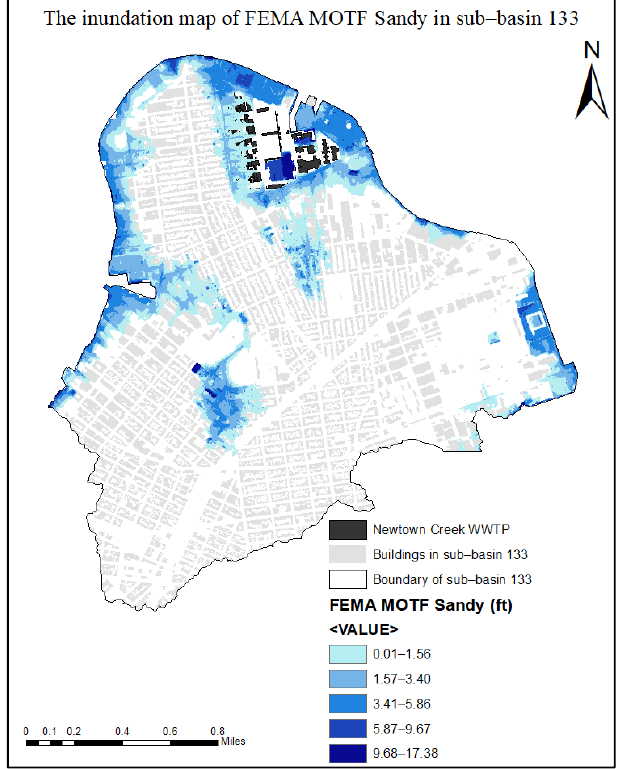
Figure 7. The inundation map of FEMA MOTF Sandy in sub-basin 133.